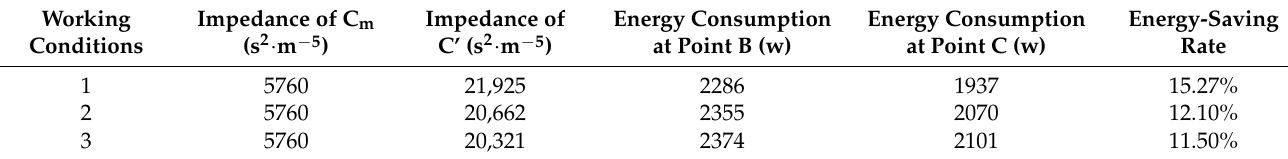
Table 5. Calculation results of three working